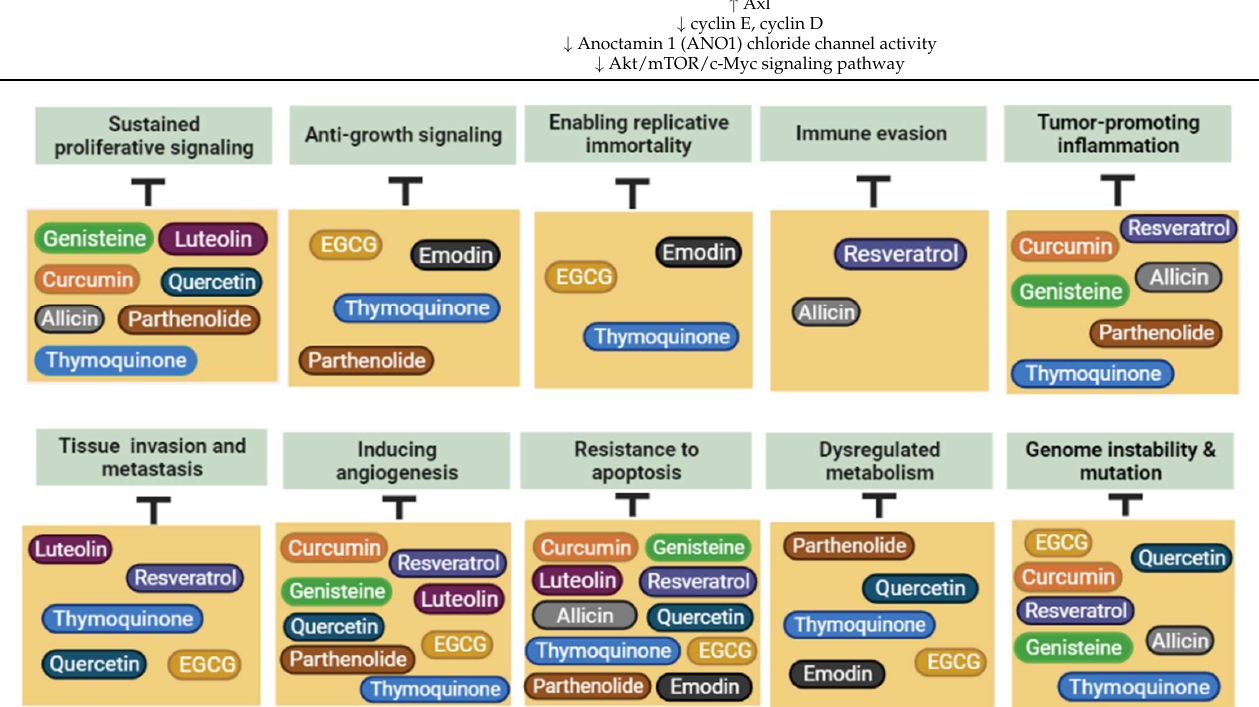
Figure 2. The effects of natural products on cancer hallmarks.